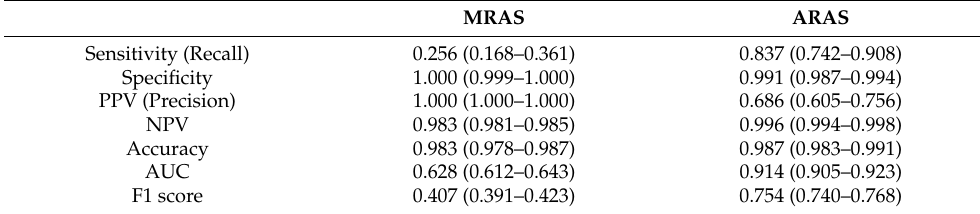
Table 2. Diagnostic performance of Manual Radiology Alert System and Automated Radiology Alert System for